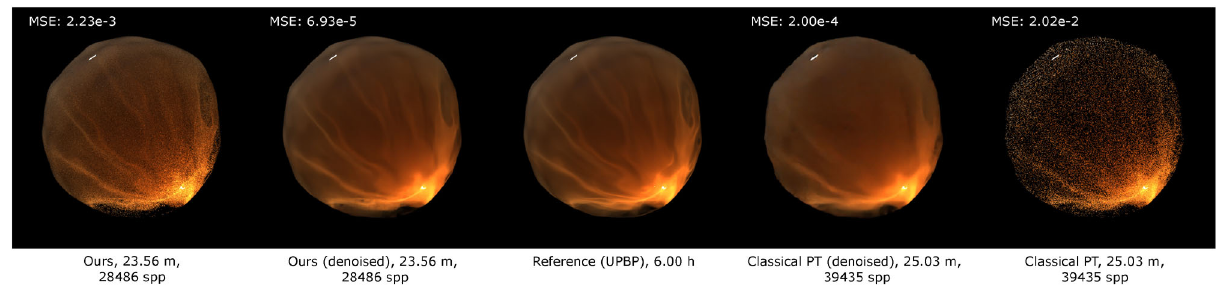
Fig. 10 Comparison of our method and path tracing with equal time for the Bumpy Sphere scene (single scattering only).